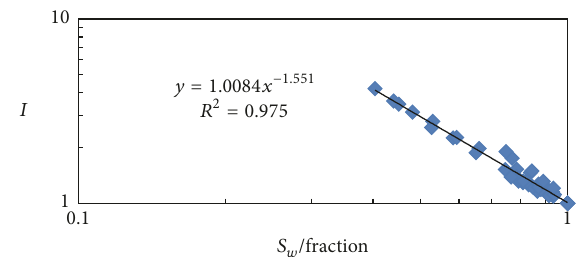
Figure 2: Relationship between the resistivity index and the water saturation of the 8